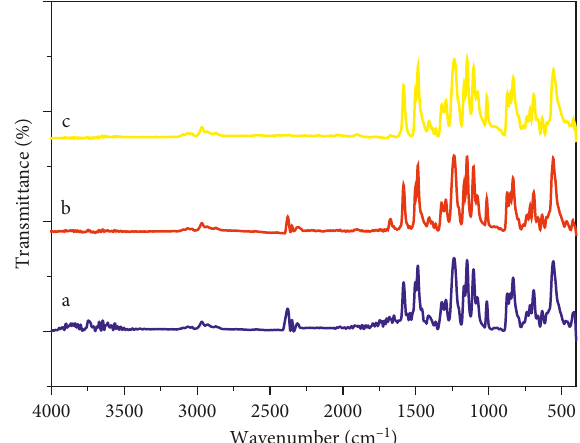
Figure 6: FTIR-ATR spectra of PSf (a), PSf/GO (b), and PSf/GO-T15 (c) membranes.